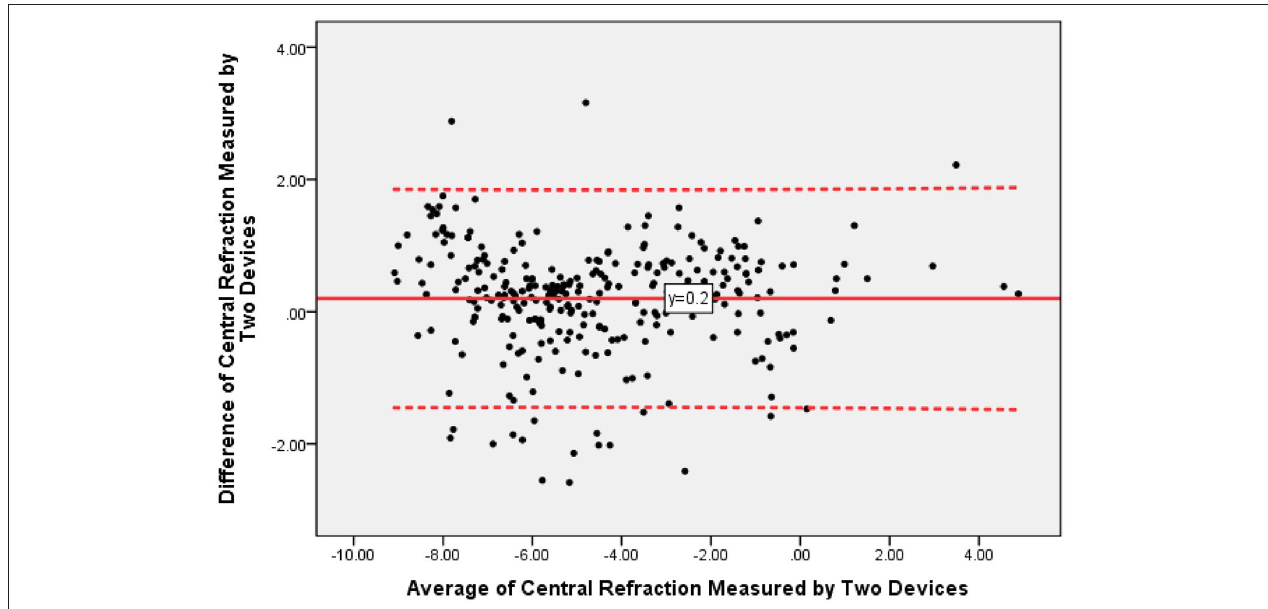
FIGURE 1 | The Bland-Altman plots of central refraction measured by multispectral refraction topography (MRT) and autorefractometer.